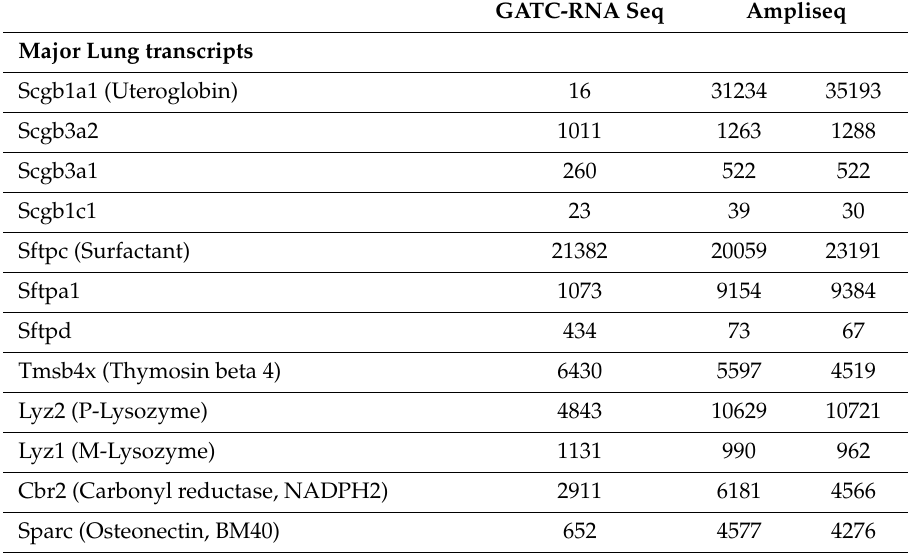
Table 4. Levels of major transcripts and MC-specific transcripts in lung (BALB / c mice). The number of normalized reads for each of the di ff erent proteases is given in actual numbers (obtained from GATC biotech and SciLife Thermo Fisher Ampliseq analyses). Two independent Ampliseq runs were